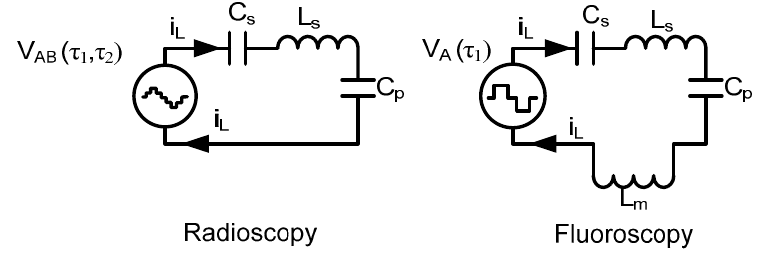
Figure 8. Resonant circuit for radioscopy and fluoroscopy.